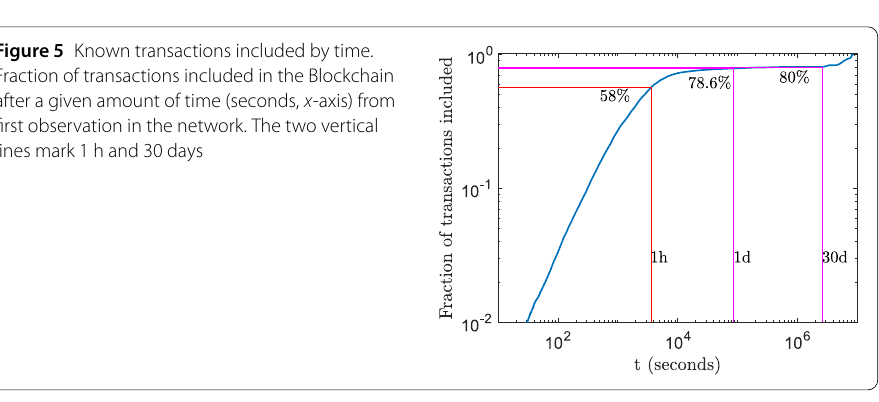
Figure 5 Known transactions included by time. Fraction of transactions included in the Blockchain after a given amount of time (seconds, x -axis) from first observation in the network. The two vertical lines mark 1 h and 30